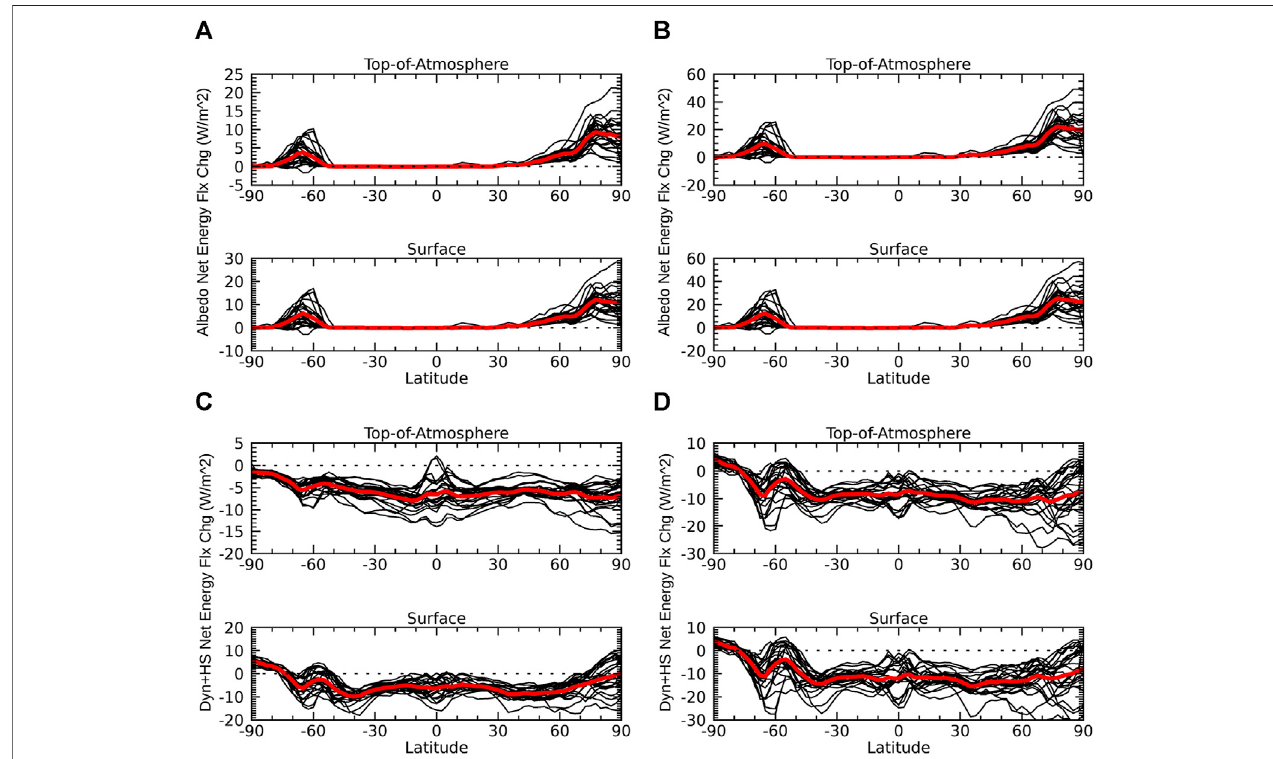
FIGURE 6 | Same as Figure 5 but due to changes in surface albedo and dynamics plus heat storage.